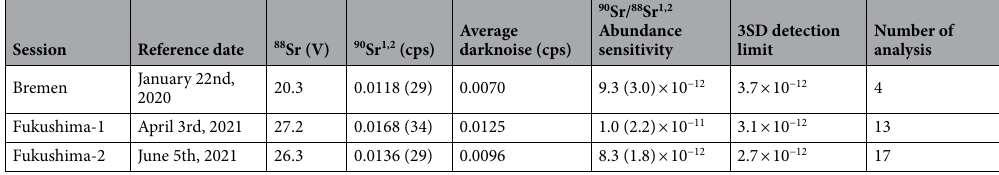
Table 1. Results of replicate measurements of NIST SRM 987 in three different mass spectrometric sessions. 1 Errors in the parenthesis are 2SD. 2 These data are not corrected for SEM dark noise.